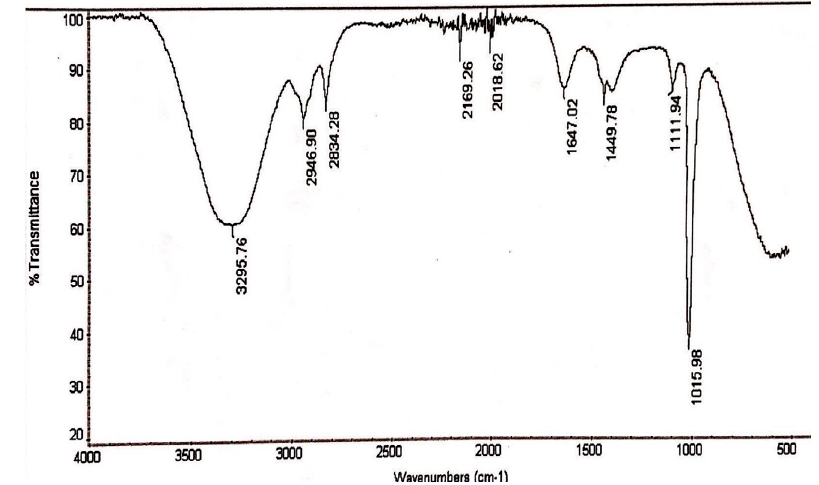
Fig. 2. IR spectrum of methanol extracts of L.nobilis